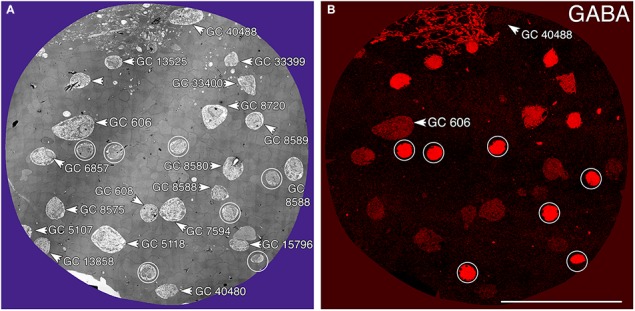
Ganglion cell - GABA colocalization in retinal connectome RC1. (A) Slice 371 TEM image displaying somas of 20 GCs (numbered) and 7 ON starburst ACs (circled). GC 606 is the largest GC soma in the volume with major and minor diameters of 34 and 19 μm. (B) Slice 371 GABA channel (Anderson et al., 2011b) with γ+ GC 606 and γ– GC 40488 labeled and starburst amacrine cells circled as in (A). Scale, 100 μm.